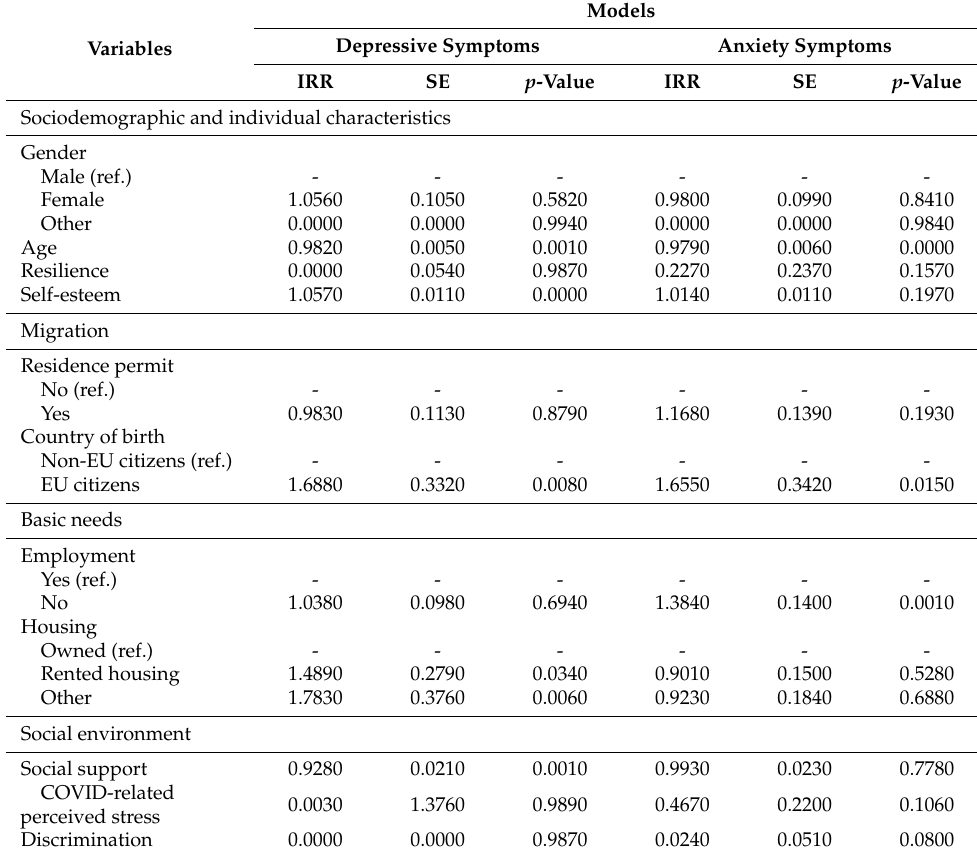
Table 2. Results from Poisson regression analyses with depressive symptoms and anxiety as outcome variables in the total